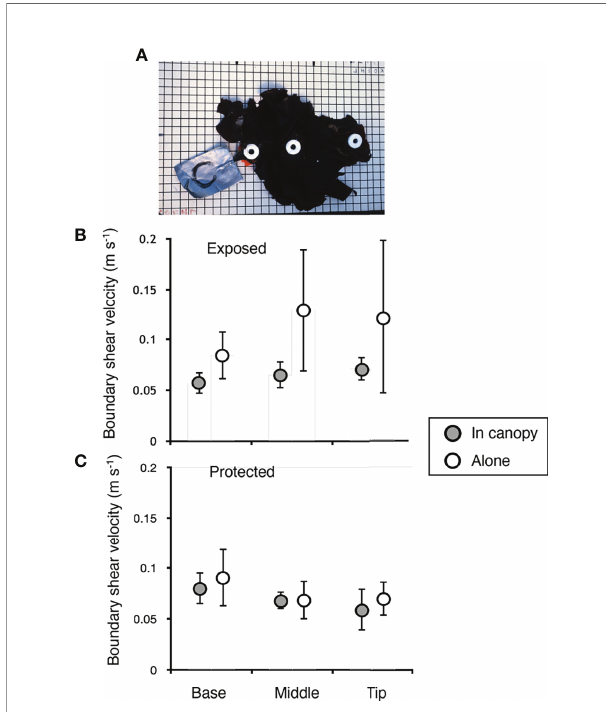
FIGURE 4 | Boundary shear velocity ( u* ) along blades of M. splendens , measured using calibrated dissolution modules. (A) Photograph of a M. splendens showing the positions at which the dissolution modules were sewn onto the thallus: base (proximal end of blade next to stipe), middle (8 cm from base), tip (distal end of blade). Duct tape attached to the stipe and holdfast of each alga was clamped to the rim of a tire on the dock so that the alga was within the canopy of M. splendens (grey circles in B and C). A second measurement of u* was done for the same individual on the same tire, but with the surrounding canopy removed (open circles in B, C ). (B) u* ’ s measured at the exposed site. At the base and at the middle of the algal blades, u* is signi fi cantly higher for algae that are alone than for algae in canopies (p < 0.05), whereas at the tip the u* ’ s of algae that are alone are not signi fi cantly higher than the u* ’ s of algae in canopies (right-tailed paired-T test, df = 3 for each position). There was no association between u* and distance from the stipe for algae that were alone or for algae in canopies (p > 0.05, two-tailed Kendall ’ s tau rank correlation test). (C) u* ’ s measured at the protected site. The u* ’ s of algae that were alone were not signi fi cantly higher than the u* ’ s of algae in canopies at any position along the blade (right-tailed paired-T test, df = 3 for each position). For algae in a canopy, there was a signi fi cant negative association between u* and distance from the base of the alga, but there was no association between u* and position along a blade for algae that were alone (p < 0.05 for signi fi cance, two-tailed Kendall ’ s tau rank correlation test). In all graphs, error bars represent one standard